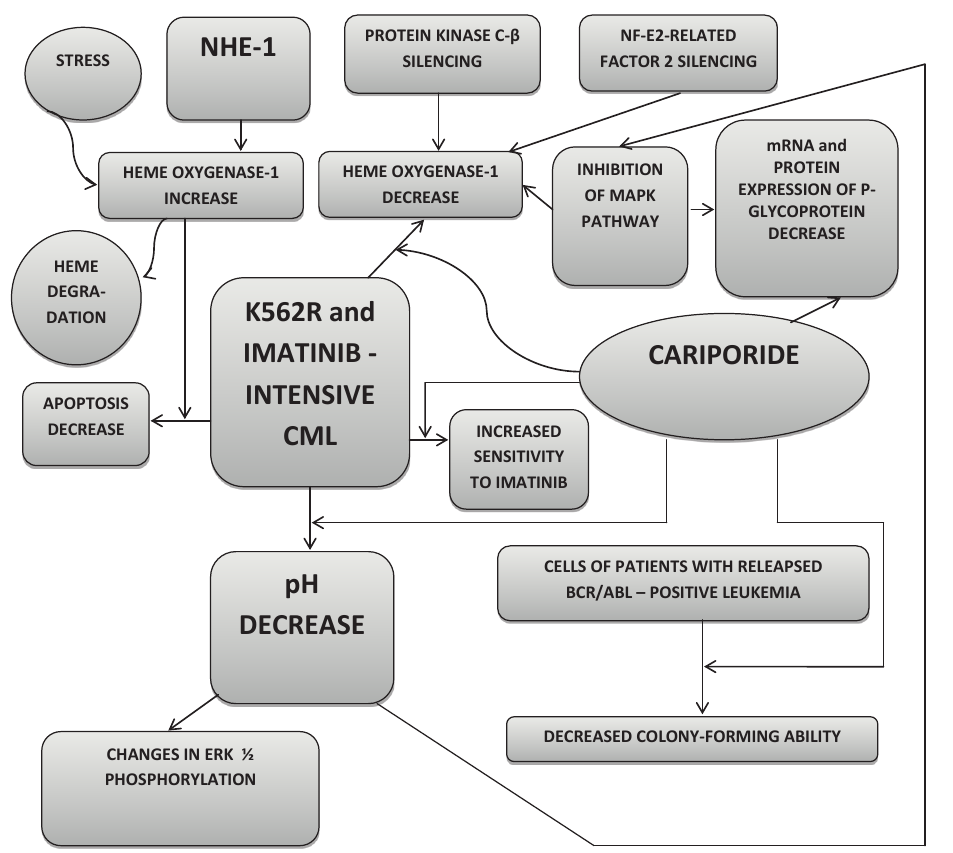
Fig. 2. The interactions in which NHE-1 and cariporide are involved in K562R cell line and imatinib-insensitive cells with chronic myeloid leukemia. CML = chronic myeloid leukemia; NHE-1= Na + /H +